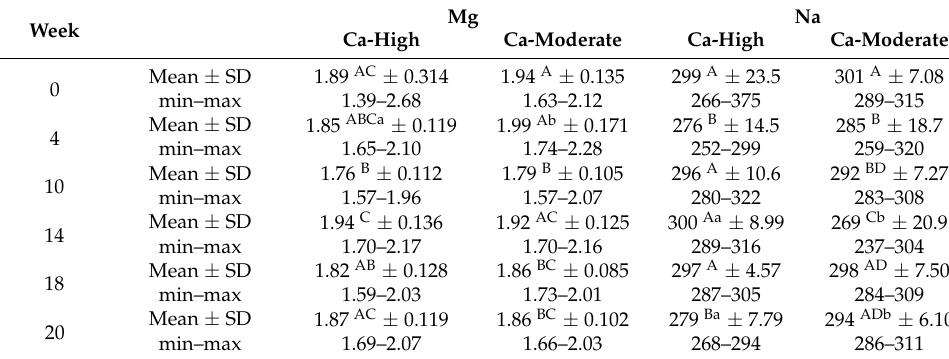
Table 6. Magnesium and sodium serum concentrations of the stallions (mean ± SD, min–max), given in